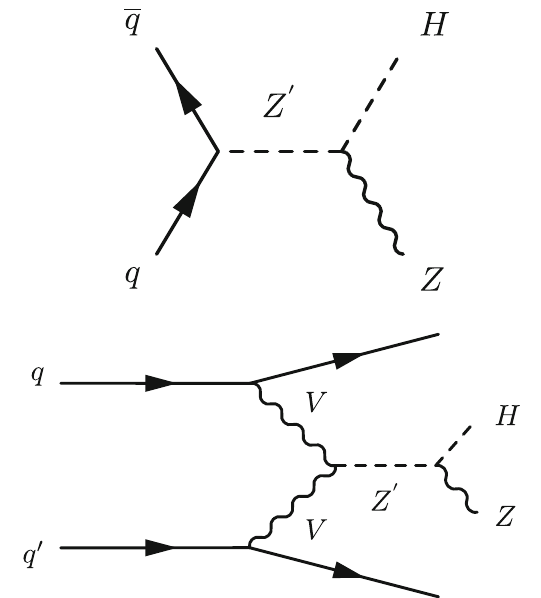
Fig. 1 The leading order Feynman diagrams of the heavy resonance Z (cid:3) production through qq annihilation (upper) and vector boson fusion (lower), decaying to a Z boson (Z) and a Higgs boson